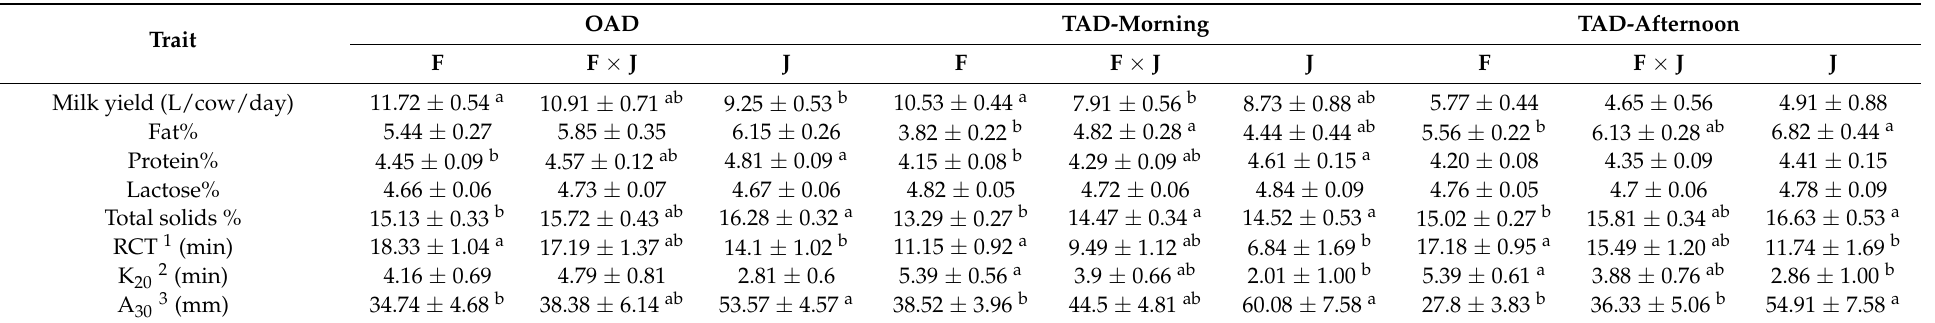
Table 4. Least-squares means and standard errors of milk composition and coagulation properties of milk from Holstein-Friesian (F), Holstein-Friesian Jersey crossbred (F × J) and Jersey (J) cows milked once-a-day (OAD) and twice-a-day (TAD) sampled in the morning and afternoon during the late lactation in